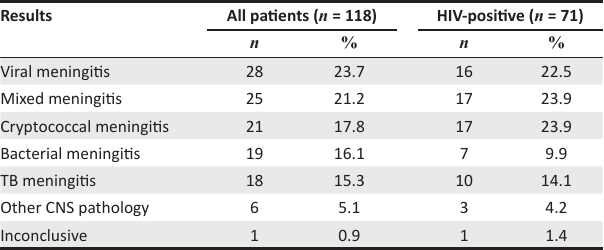
TABLE 3: Lumbar puncture results of total study population and patients who are HIV-positive. Results All patients ( n =